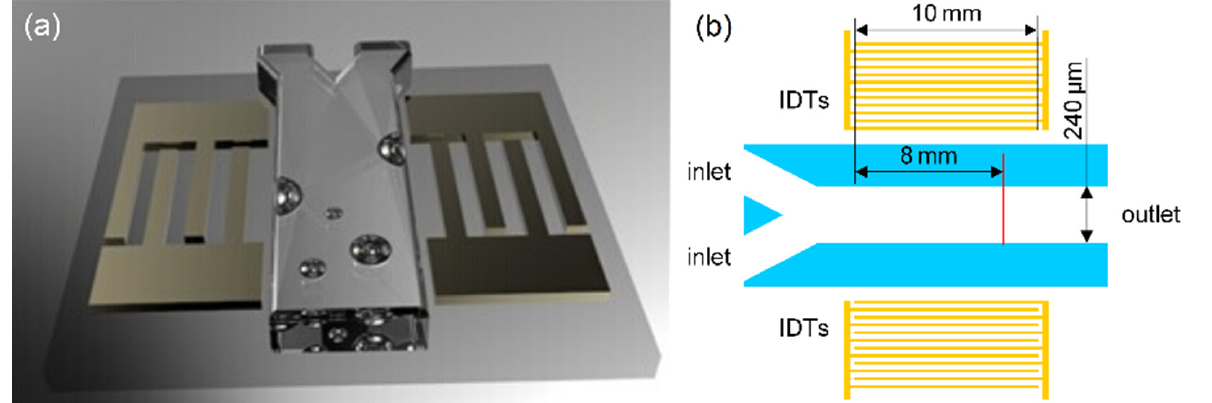
Figure 1. Schematic of the assembled SSAW mixing device: ( a ) 3D schematic and ( b ) 2D schematic. The acoustic aperture of IDTs is 10 mm. The main channel is 240 μ m in width. The dimension ratios in ( a , b ) do not match the real ones. The propagating SSAW wavelength is defined by the IDTs’ finger width and spacing, both of which were designed as λ /4. Actuated by the SSAW, a mixing process can be expected.